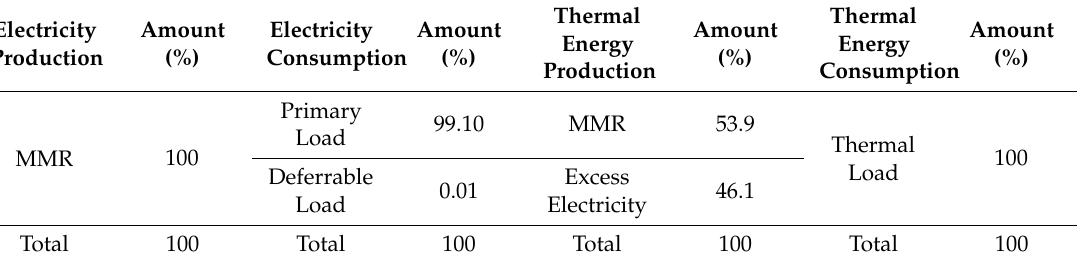
Table 14. Energy production and consumption scenario of o ff -grid mode for the first year of project life (case-04).